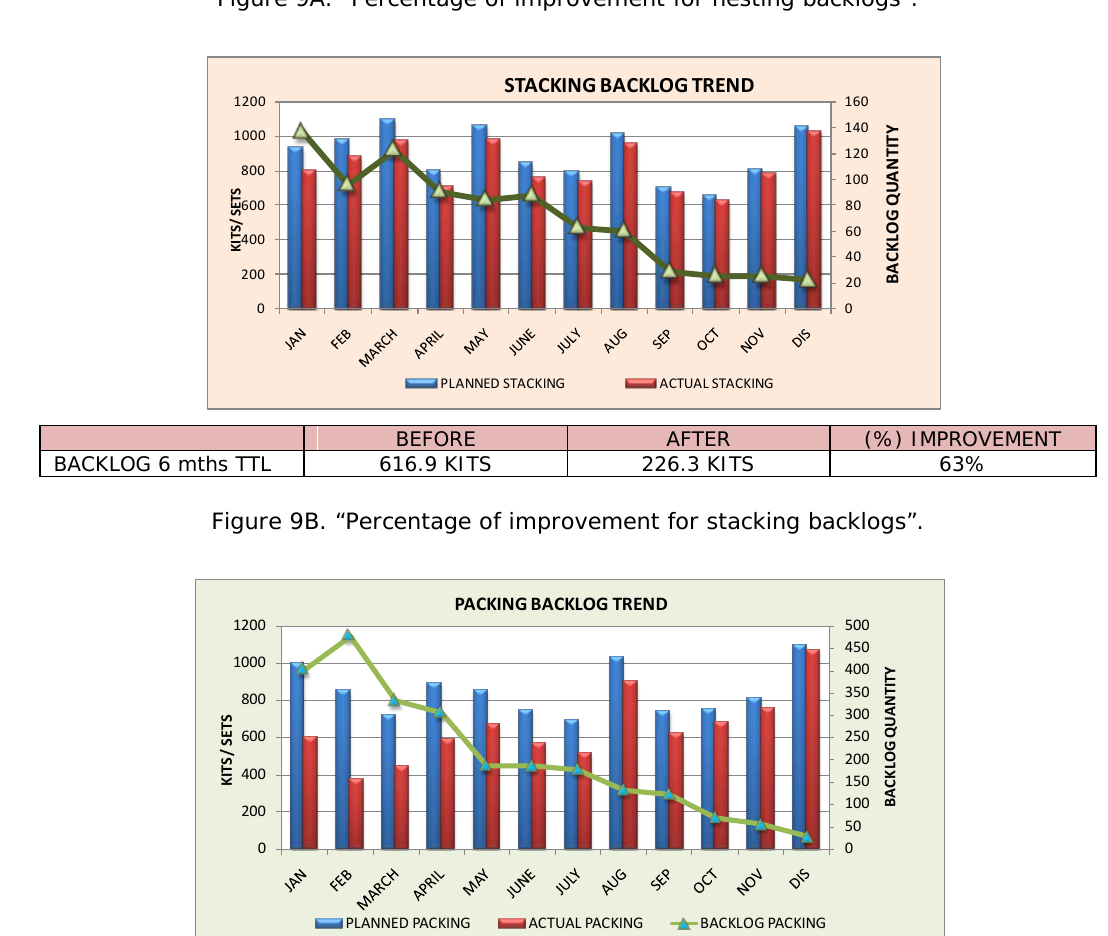
Figure 9A. “Percentage of improvement for nesting backlogs”.